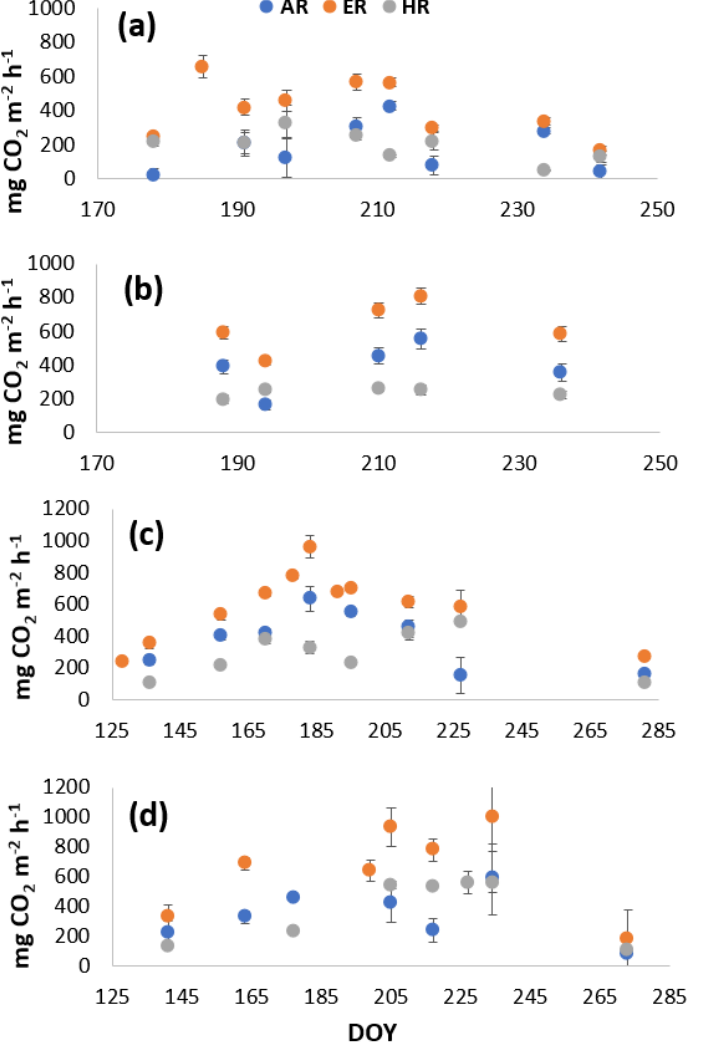
Figure A2. Average CO 2 fluxes in the (a) shrub plots and (b) sedge plots across the growing season of 2018, and CO 2 fluxes in the (c) shrub plots and (d) sedge plots across the growing season of 2019.